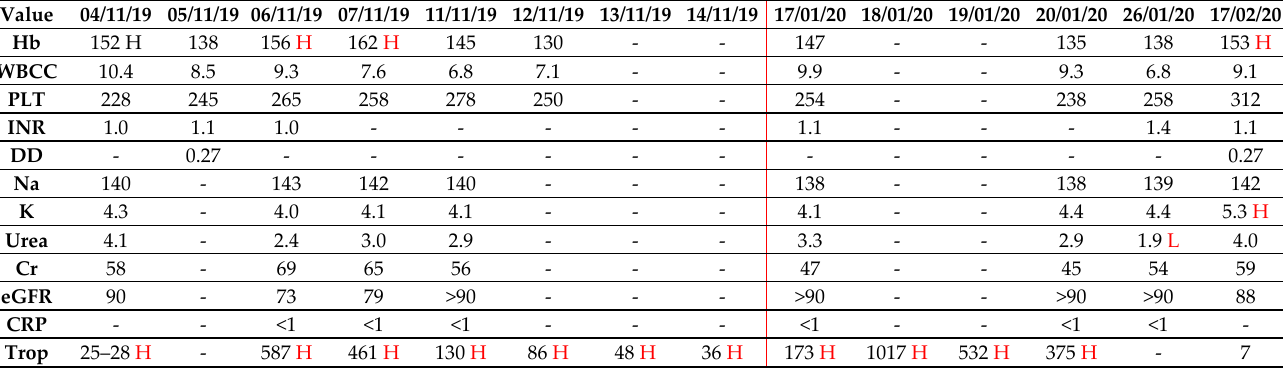
Table 1. Hematology results taken on both admissions.